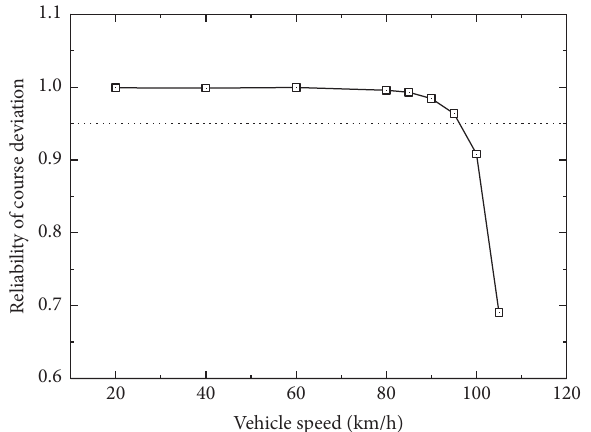
Figure 8: Reliability with vehicle speed (course deviation).